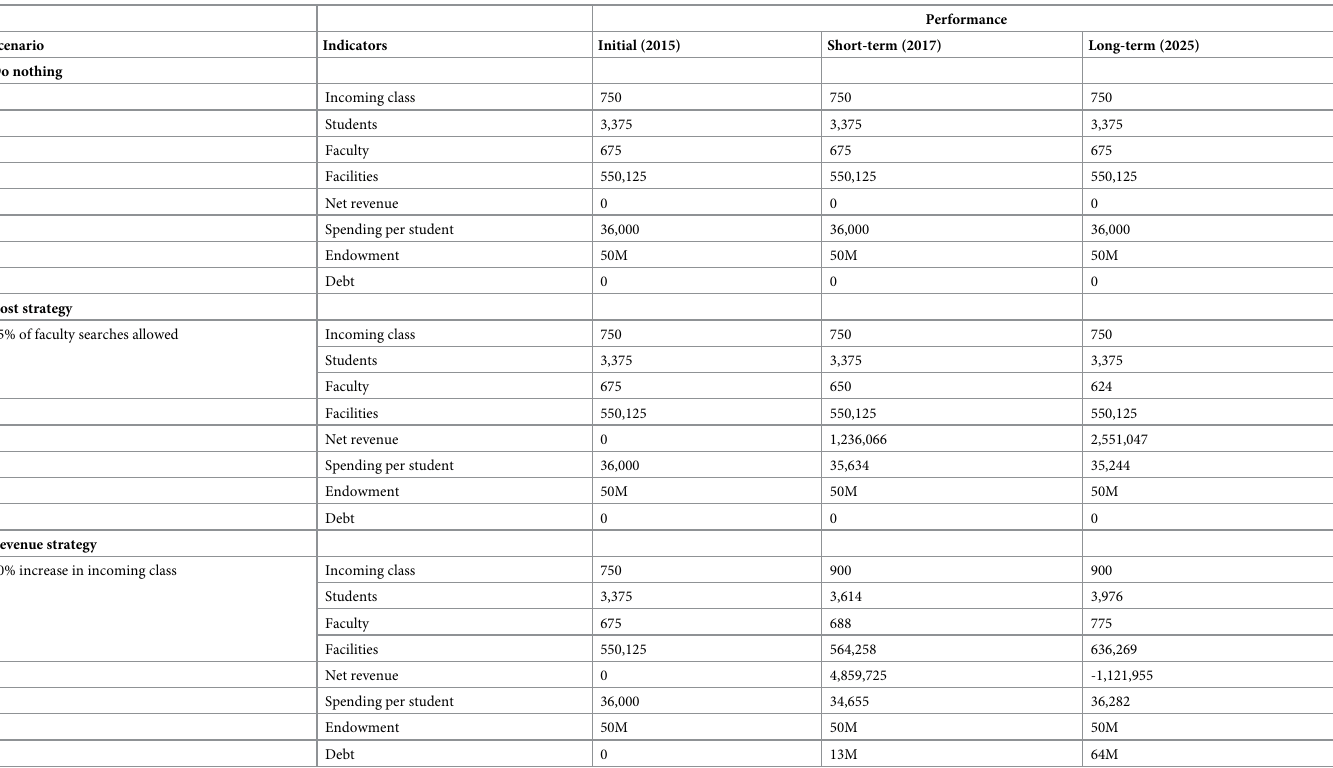
Table 3. College performance when application decline by five